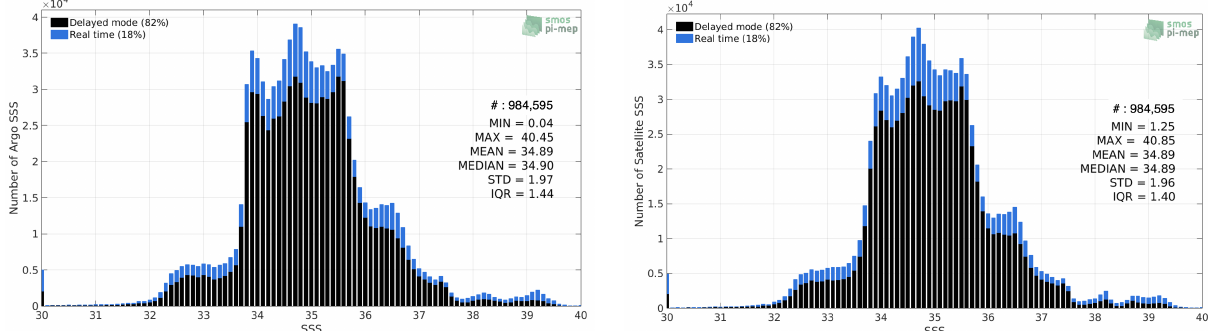
Figure 4. Histograms of SSS from Argo ( left ) and CCI SSS L4 Merged-OI v3.2—30-day running (ESA) ( right ) considering all match-up pairs per bins of 0.1 over the Global Pi-MEP region and for the full satellite product